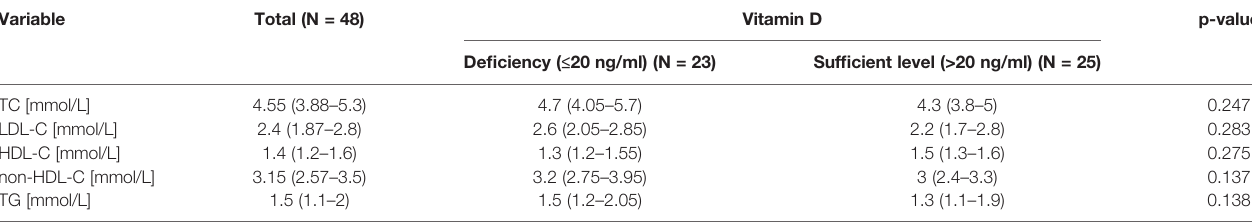
TABLE 4 | Lipid pro fi le parameters in the entire cohort divided into subgroups according to 25(OH)D concentrations. Variable